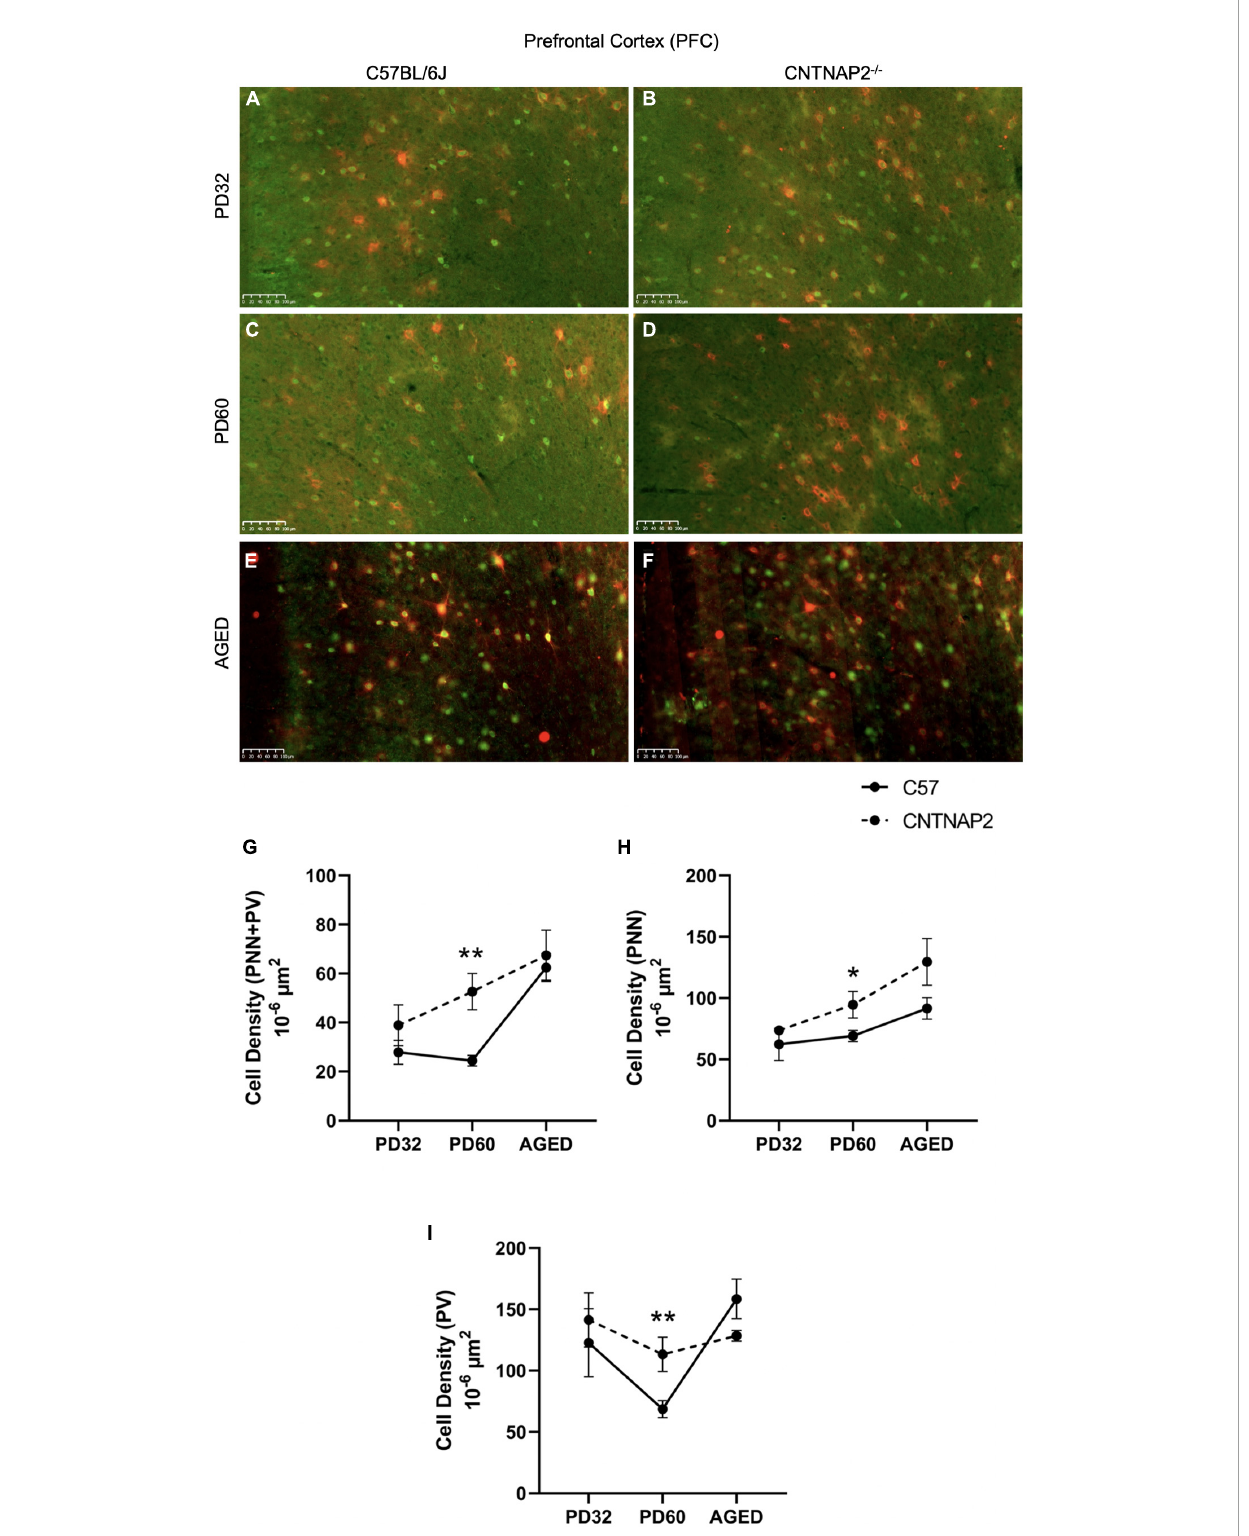
FIGURE1 Expression of perineuronal nets (PNNs) and parvalbumin-positive interneurons (PVs) in the prefrontal cortex (PFC) of C57BL/6J and CNTNAP2 − / − mice. (A–E) Immunofluorescence images depicting co-localized PNNs and PV-positive cells in prefrontal cortex (PFC) of C57BL/6J (left images) and CNTNAP2 − / − (right images) mice at PD 32 (A,B) , PD 60 (C,D) , and PD 395-425 (aged) (E,F) . Scale bar 100 µ m. (G–I) Quantitative estimation of PNNs co-localized with PV-positive neurons (G) , PNNs (H) , and PV-positive cells (I) in prefrontal cortex (PFC) of C57BL/6J ( n = 3–7) and CNTNAP2 − / − ( n = 3–6) mice at different postnatal ages. Significance levels (*, **) are as noted in the